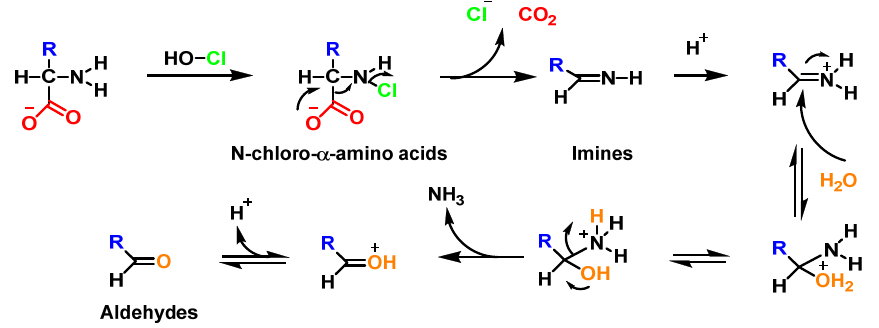
Figure 40. Degradation mechanisms of N-chloro- α -amino acid anions under neutral conditions.